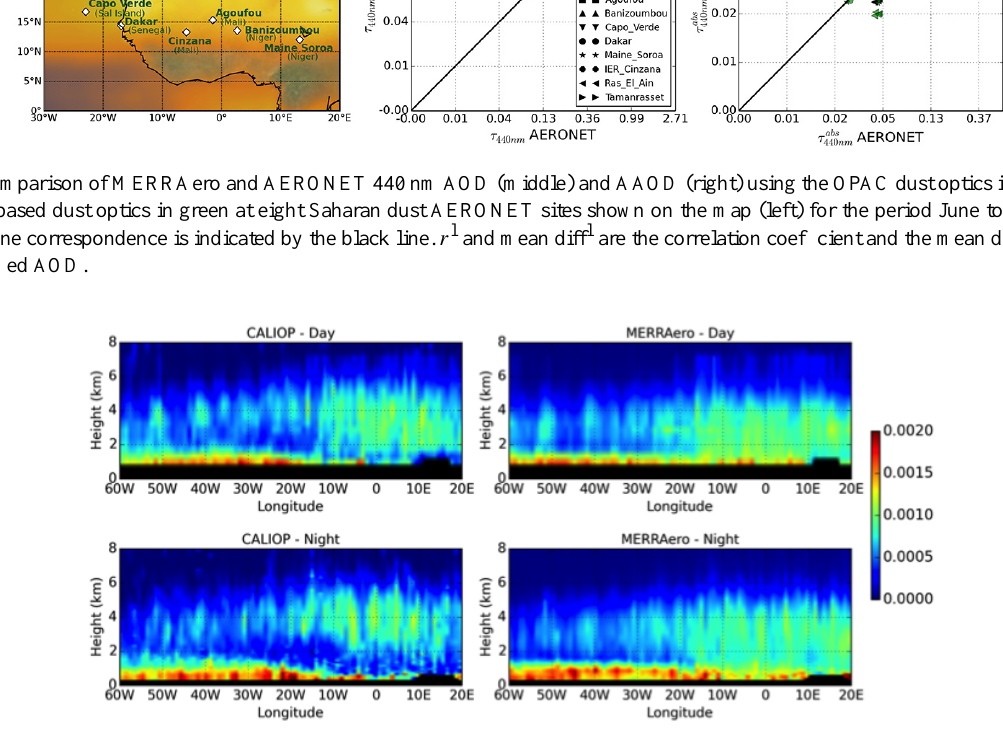
Figure 6. On the left, regional 3-month average (JJA 2007) of CALIOP attenuated backscatter coefficient (km − 1 sr − 1 ) at 532nm over the African dust region (60 ◦ W–20 ◦ E, 0–30 ◦ N) during the day (top) and the night (bottom). On the right, MERRAero attenuated backscatter coefficient sampled on the CALIPSO track for the same period during the day (top) and night